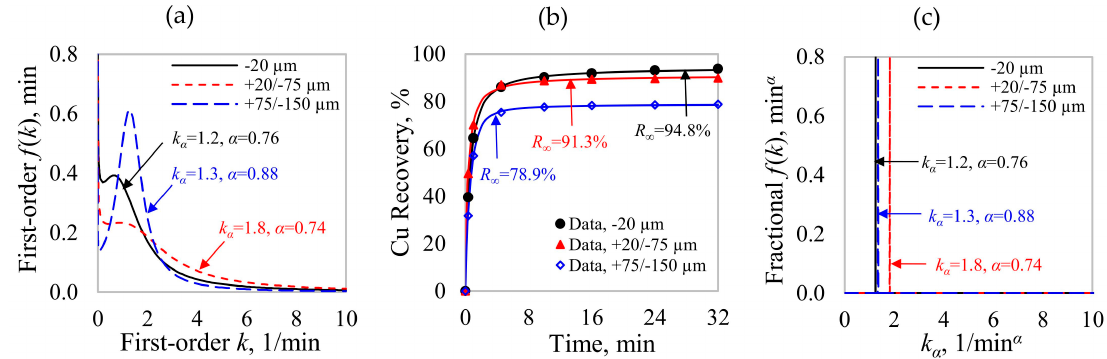
Figure 8. Examples of estimated f ( k )s and model fitting, size-by-size Cu results; ( a ) First-order f ( k )s, Equation (14), ( b ) Time-recovery data, continuous curves obtained by fitting the R ( t ) model of Table 6, ( c ) Fractional f ( k )s.